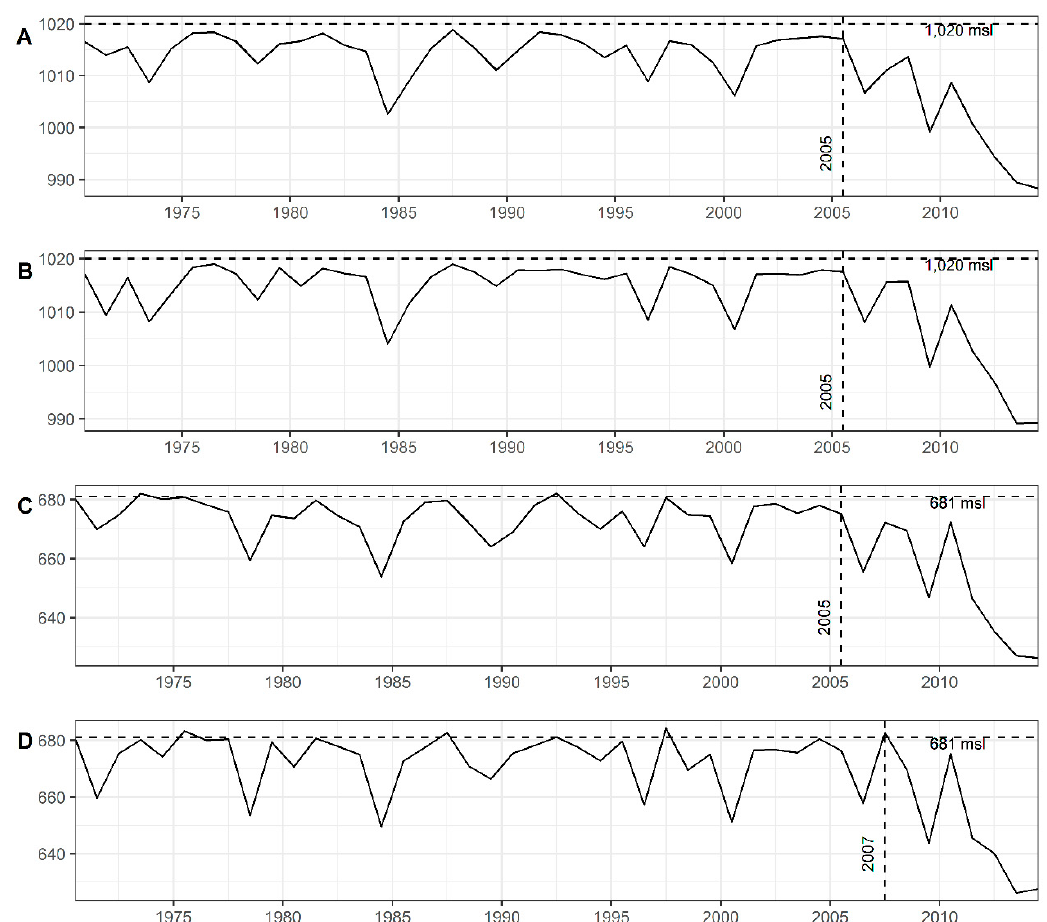
Figure 3. Change points for lake characteristics: Lake Buchanan ( A ) annual mean level and ( B ) annual summer level and Lake Travis ( C ) annual mean level and ( D ) annual summer level from 1970 to 2014. Each lake level measured in feet above mean sea level (msl). Horizontal dashed line represents the level (msl) when the lake is at capacity.